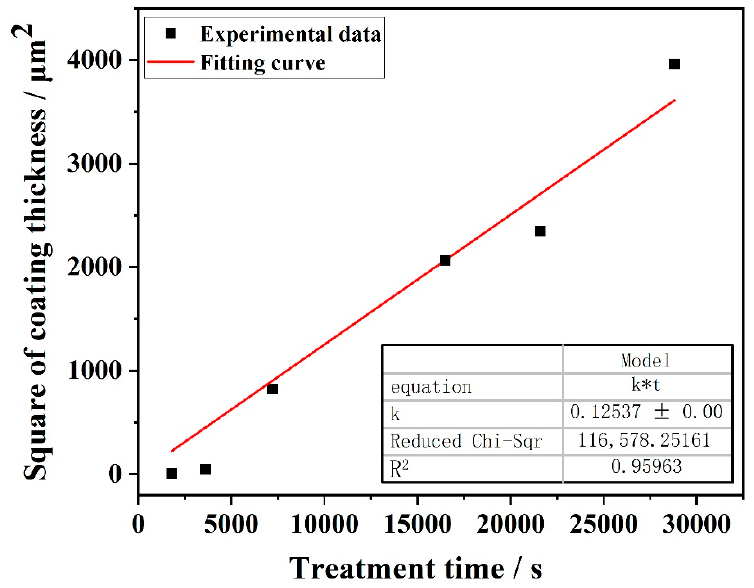
Figure 5. Square of the coating thickness versus boriding time and fitting curve.